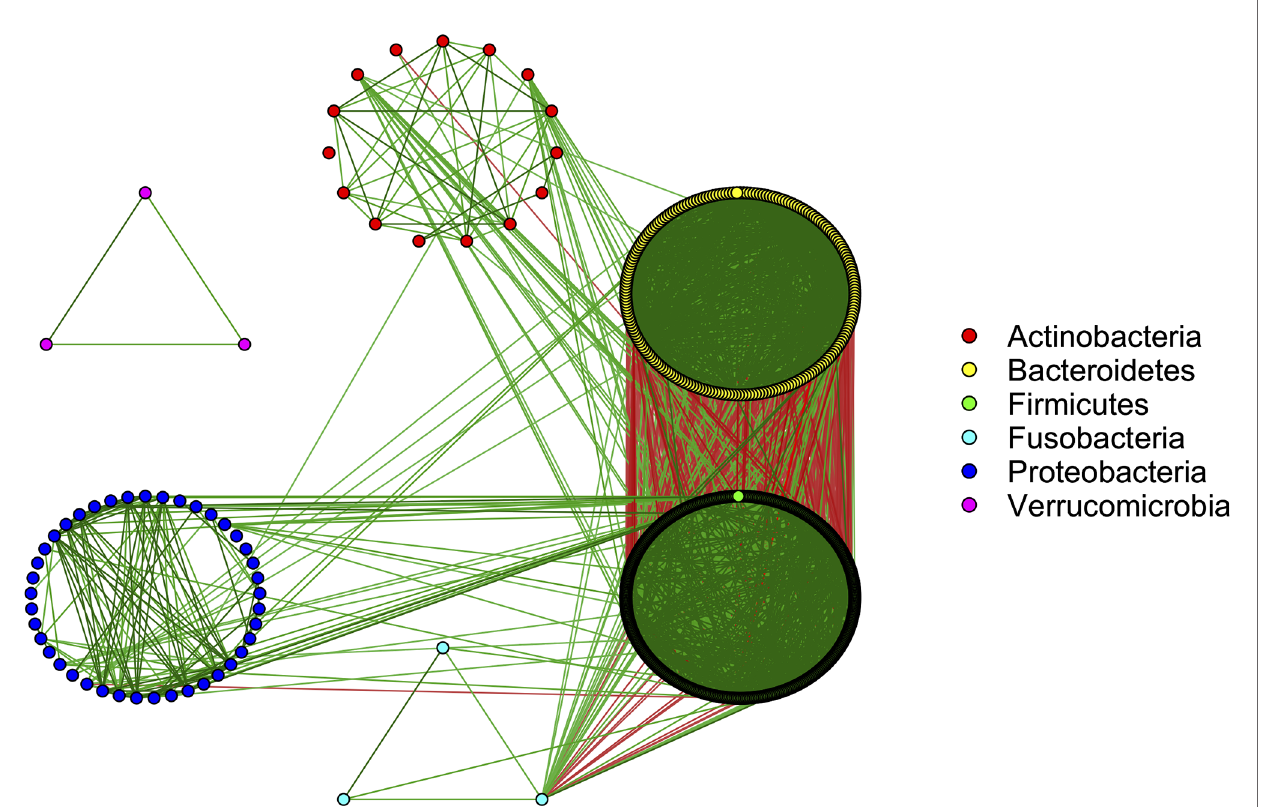
FIGURE 2 | Co-occurrence network showing strong interactions in the microbiome community (SparCC correlations >0.5 and <-0.5). Green/red edges correspond to positive/negative relationships. The color of each node corresponds to the phylum of the given